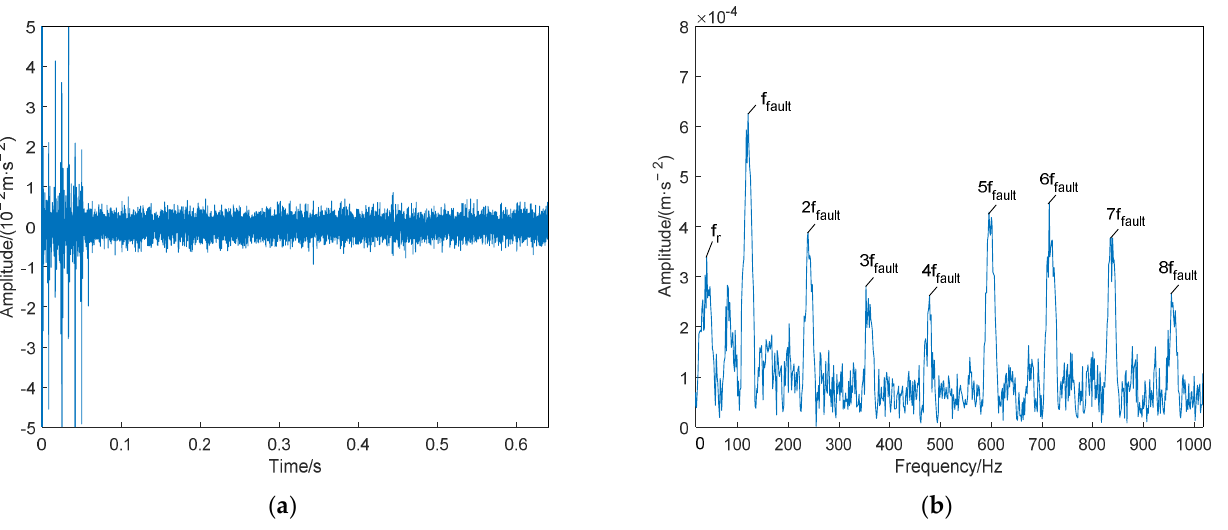
Figure 10. Time-domain waveform and envelope spectrum after MCKD processing: ( a ) time-domain graph after MCKD processing; ( b ) envelope spectrum after MCKD processing.